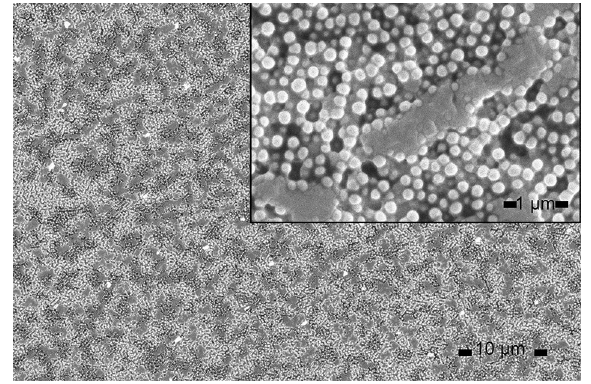
Figure 6. SEM images of the puncturing mechanism of the cicada wing mimicry.